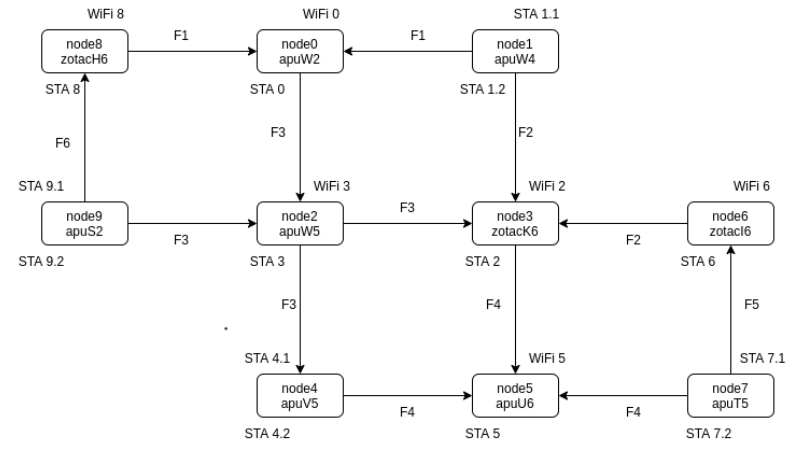
Figure 11. W-iLab2.t grid topology node setup.